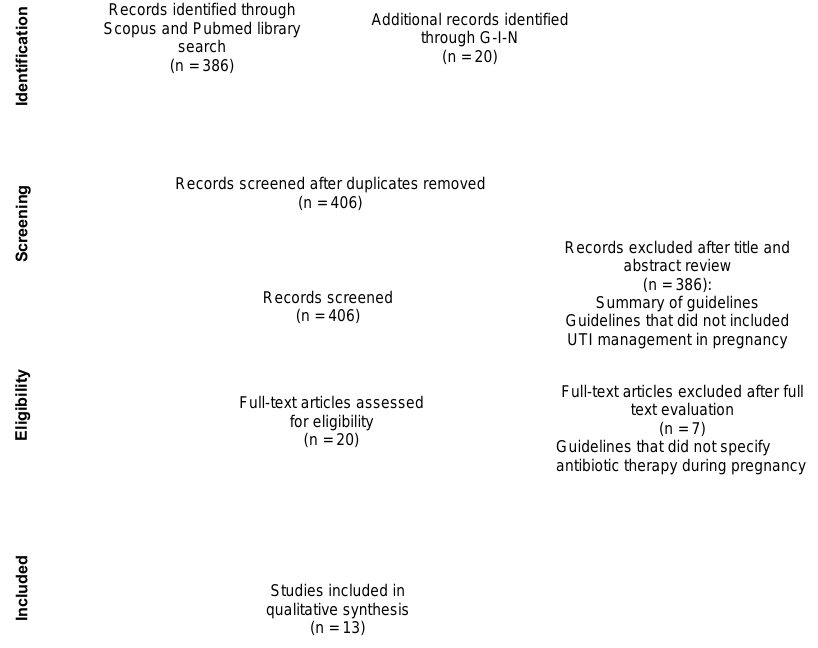
Figure 1. Flow chart of the literature review.